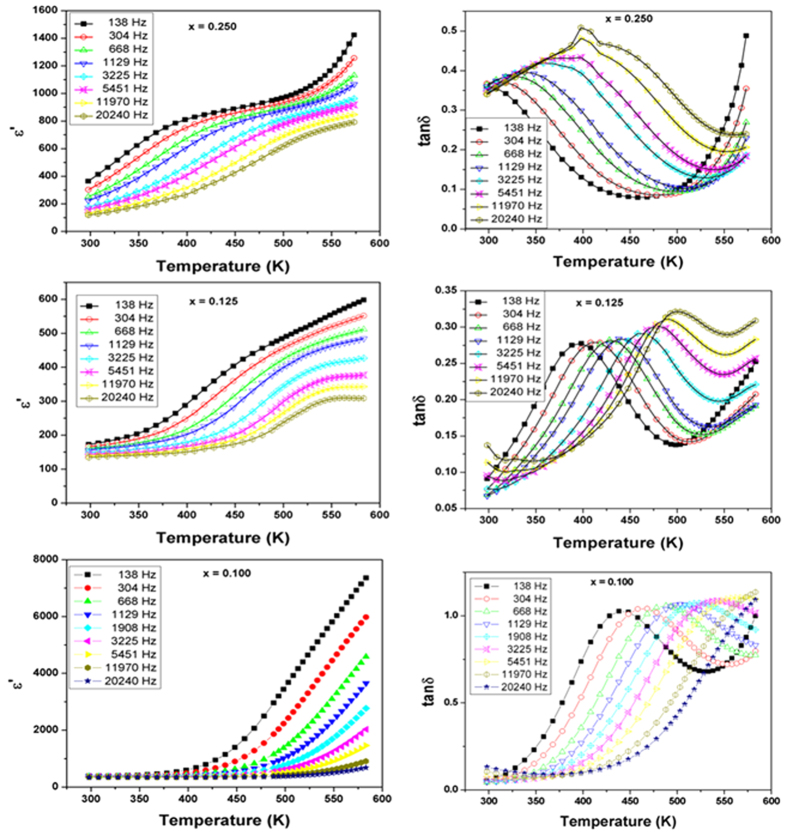
Variation of real part of relative permittivity and tan δ with temperature for biphasic compositions in SrTi1−2xFexTaxO3 compositions (x = 0.10, 0.125, and 0.25).